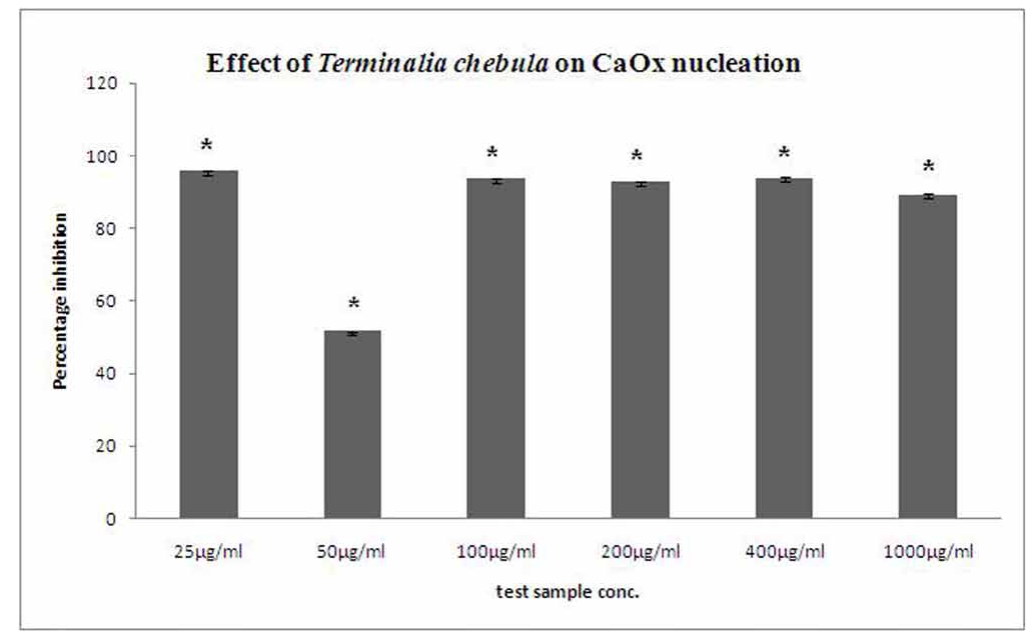
Figure 1 – Effect of crude extract of Terminalia chebula on nucleation of CaOx. Data are mean ± S.D. of three independent observations.* p <